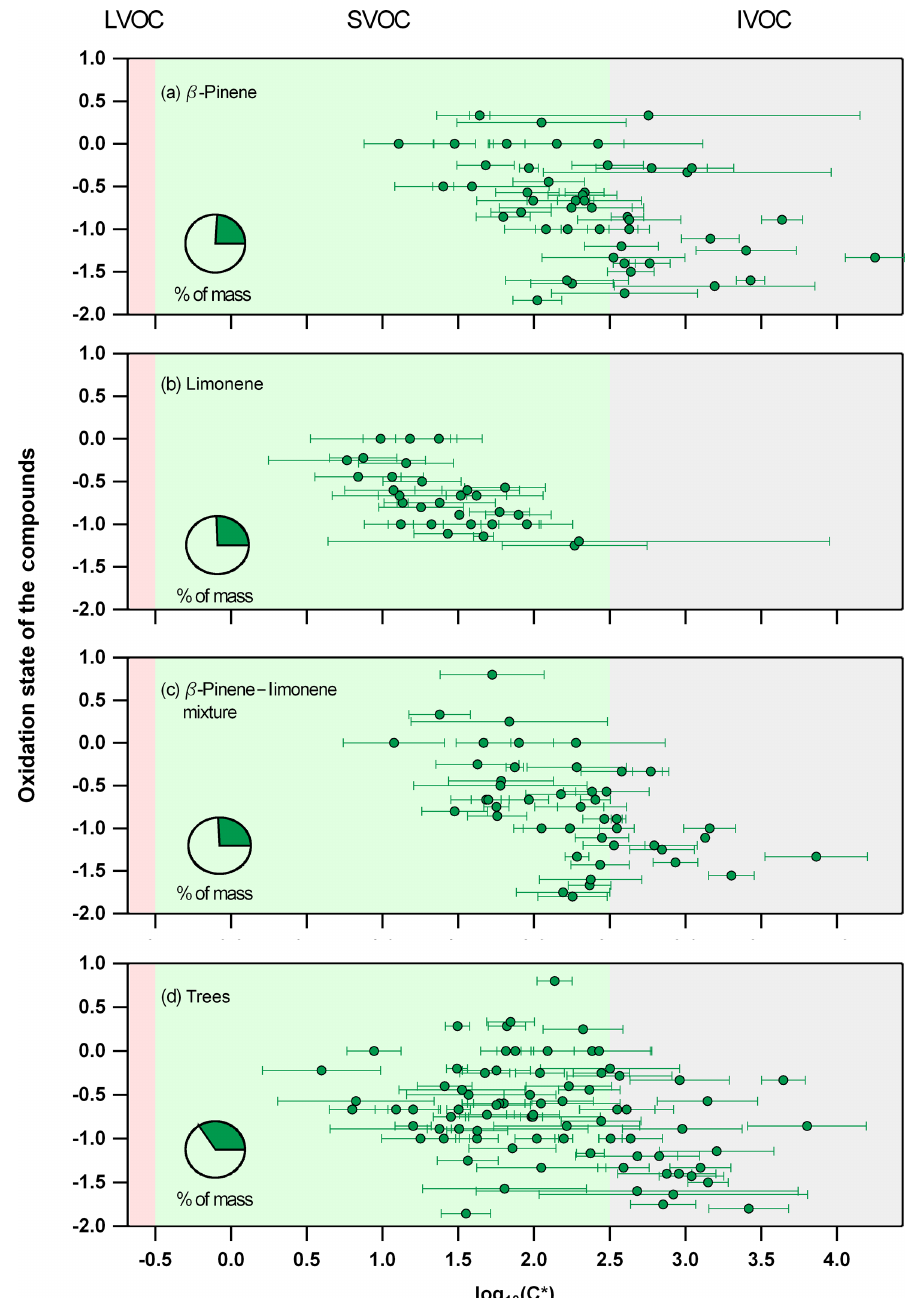
Figure 3. The average experimental saturation concentration for detected ions (from ACM, CHARON, or TD) that act as parent ions identified using the described selection criteria during the (a) β -pinene, (b) limonene, (c) mixture of β -pinene and limonene, and (d) the real tree emissions experiments. Error bars indicate the ± 1 σ of the experimental average. Pie charts show the percent of mass (green) measured when adding all presented ions compared to the total organic mass obtained from the